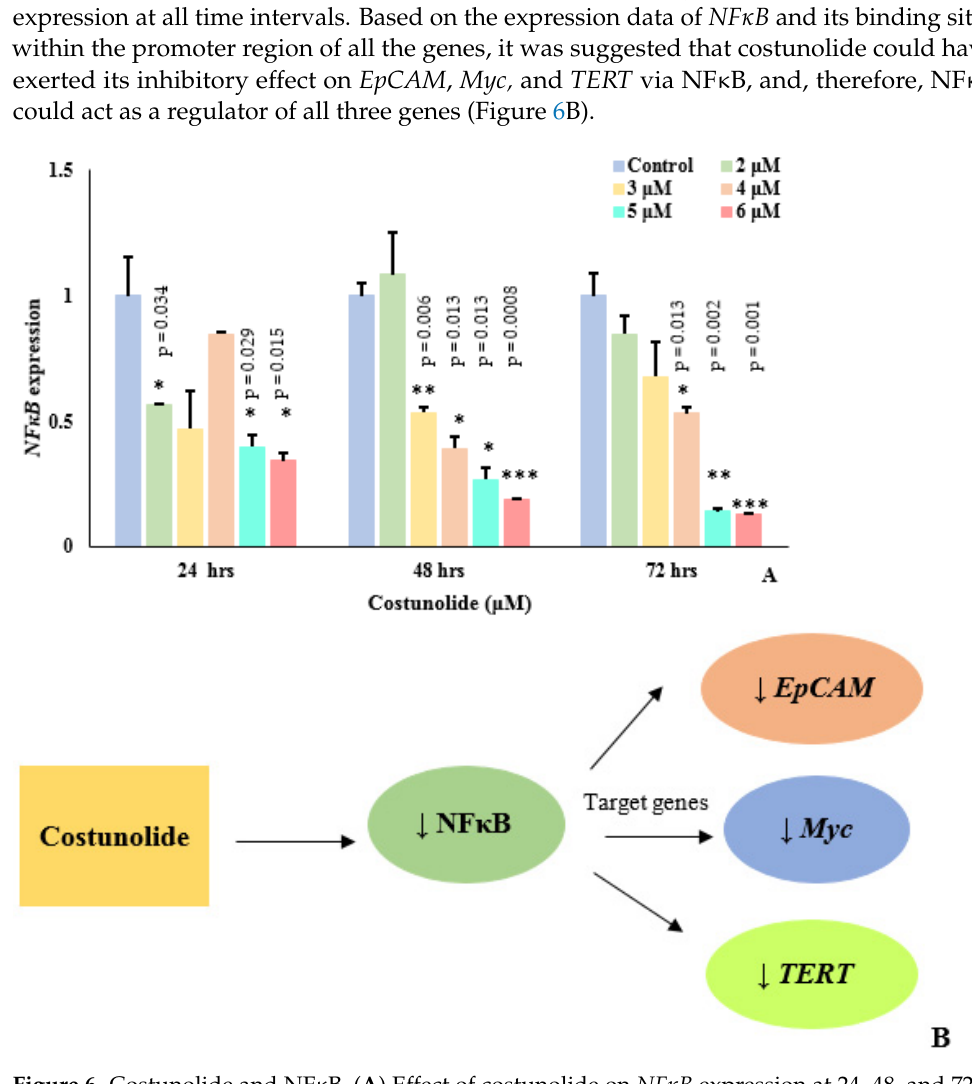
Figure 6. Costunolide and NF κ B. ( A ) Effect of costunolide on NF κ B expression at 24, 48, and 72 h. Error bars represent standard error of mean. *, **, *** indicate p values < 0.05, < 0.01, and < 0.001 (One-way ANOVA). ( B ) Inhibitory effect of costunolide on EpCAM , Myc, and TERT via NF κ B.